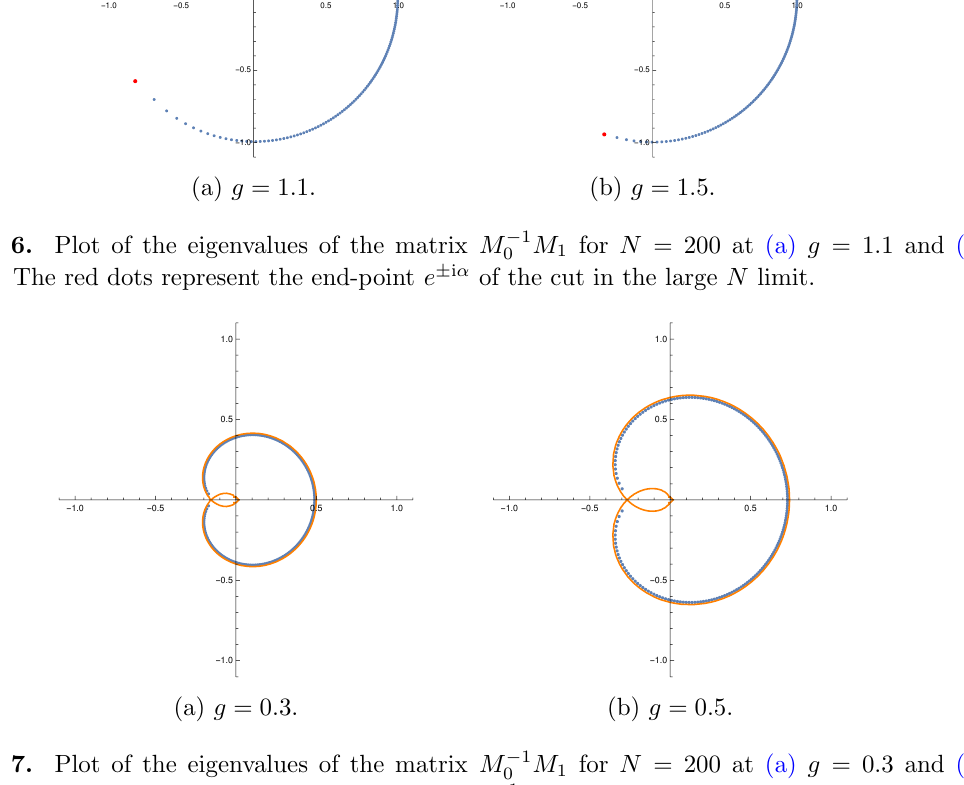
Figure 7. Plot of the eigenvalues of the matrix M (cid:0) 1 g = 0 : 5. The dots are the eigenvalues of matrix M (cid:0) 1 equi-potential contour (cid:8)( z ) = (cid:0) S inst ( g